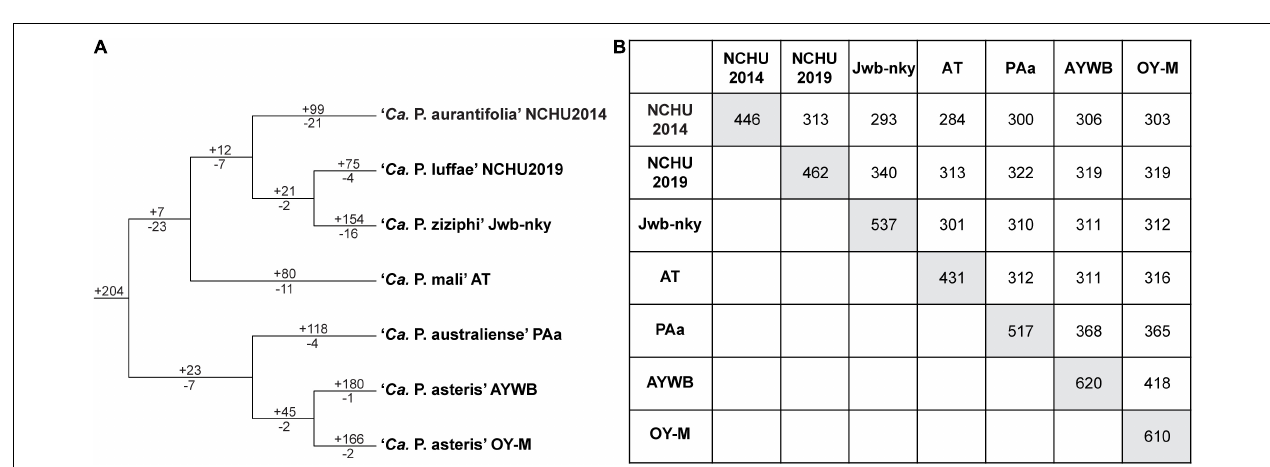
FIGURE 5 | Distribution patterns of homologous gene clusters. (A) Phylogenetic distribution. The cladogram was based on a maximum likelihood phylogeny inferred using 204 shared single-copy genes; the concatenated alignment contains 72,653 aligned amino acid sites. Numbers above a branch and preceded by a “ + ” sign indicate the number of clusters that are uniquely present in all daughter lineages; numbers below a branch and preceded by a “–” sign indicate the number of clusters that are uniquely absent. (B) Numbers on the diagonal indicate the counts of homologous gene clusters found in each of the Candidatus species genomes; numbers above the diagonal indicate the counts of homologous gene clusters shared in pairwise